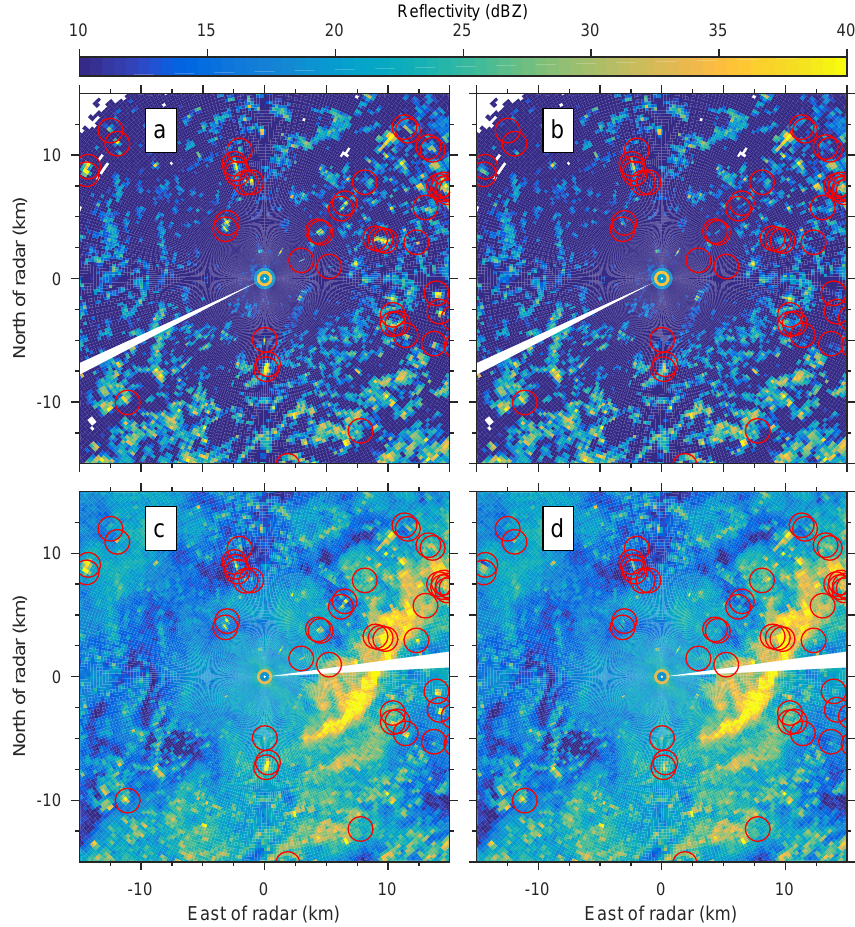
Figure 10. Filtering the impact of wind turbines. Top row shows recreated reflectivity data from 9 September 2016 at 09:00UTC. No precipitation occurred near the radar Vara at this time. Panel (a) shows recreated reflectivities from the original I/Q data, with the positions of known wind turbine marked by red circles. Panel (b) shows recreated reflectivity data after applying a wind turbine filter to the I/Q data. The bottom row shows recreated reflectivity data from 28 September 2016 at 04:00UTC. During this time rain bands passed over the radar Vara from the west. Panel (c) shows recreated reflectivity from the original I/Q data, while panel (d) shows filtered, recreated